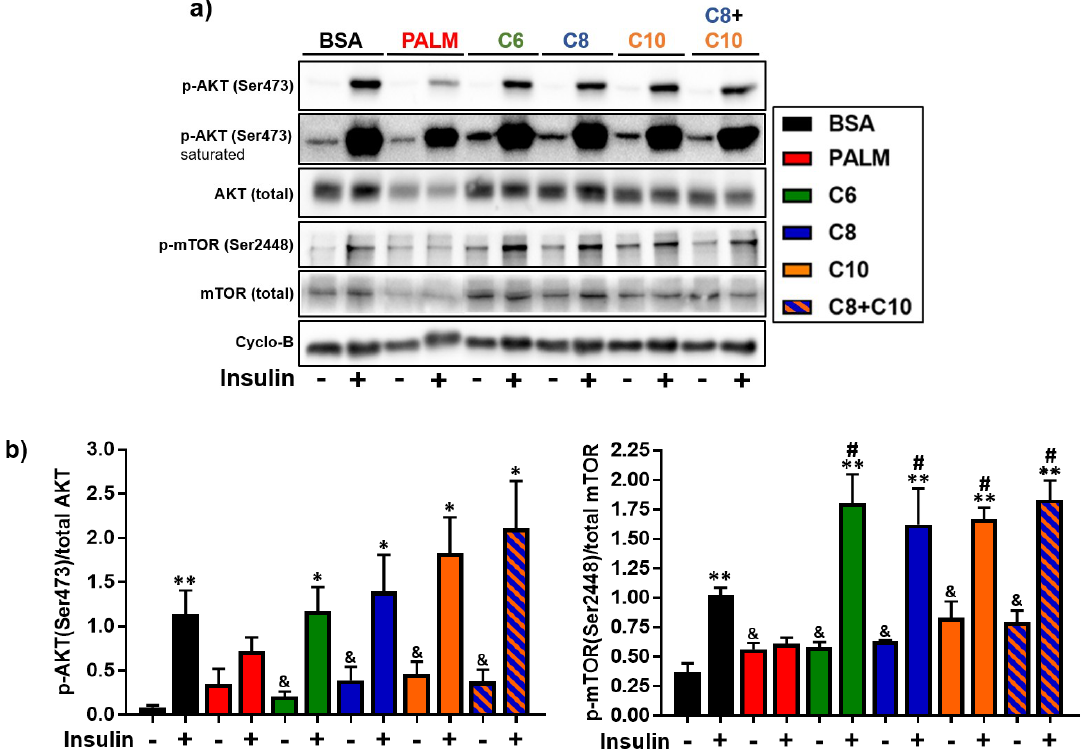
Figure 6. Effect of fatty acids on the insulin-induced signaling cascade in HepG2 cells. HepG2 cells were treated 24 h with 0.25 mM PALM, C6, C8, C10, a C8 + C10 equimolar mix, or vehicle control (BSA) then stimulated (+), or not ( − ), with 100 nM insulin for 10 min. ( a ) Representative Western blots of total and phosphorylated Akt (Ser473), total and phosphorylated mTOR (Ser2448), and Cyclophilin-B loading control ( n = 4). ( b ) Quantification of phosphorylation levels normalized to total levels. * p -value < 0.05, ** p -value < 0.01 < 0.001 versus non-insulin stimulated. # p -value < 0.05 versus insulin-stimulated BSA control. & p -value < 0.05 versus non-insulin stimulated BSA control.